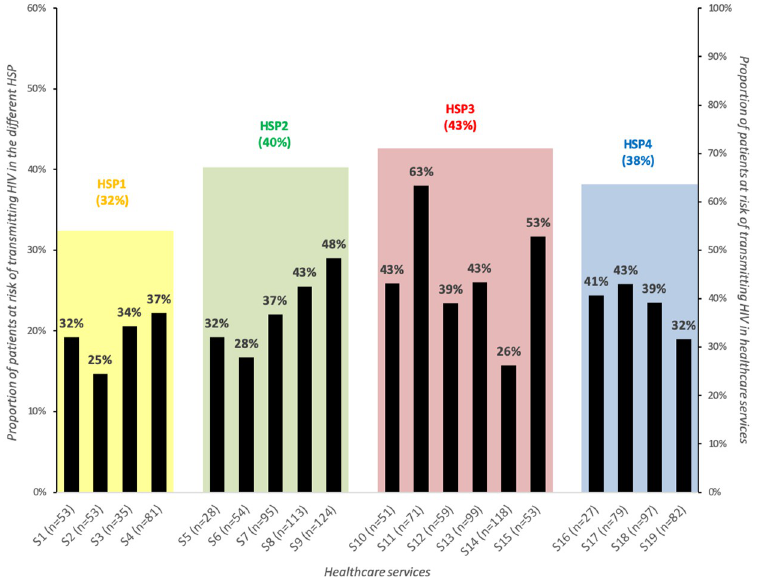
Fig 3. HIV transmission risk across HIV services and HIV-service profiles (EVOLCam survey, ANRS 12288). Abbreviations: HSP = HIV service profiles. The names of the participating HIV services are anonymized and numbered from 1 (S1) to 19